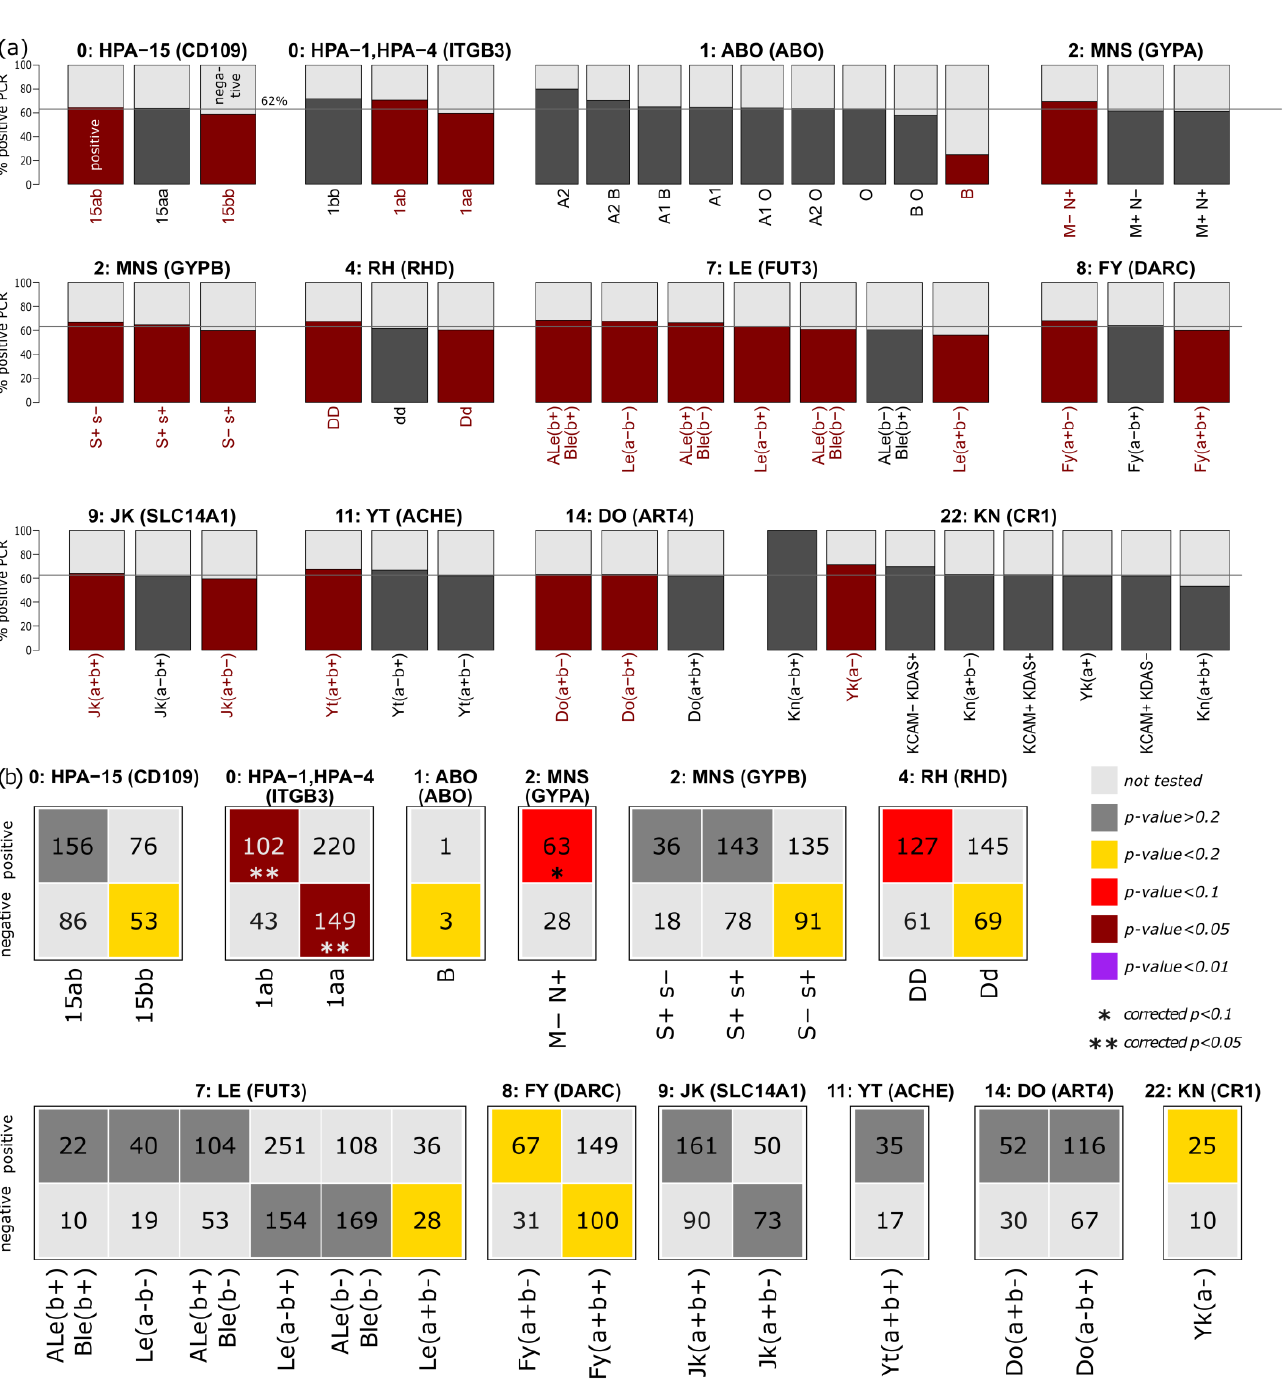
Figure 4. ( a ) Percent of persons with positive PCR, stratified by the blood groups. Groups with corrected p -values < 0.05 are highlighted in red (see description of Figure 2). ( b ) Contingency tables of the selected phenotypes (corrected p -value < 0.05). Numbers refer to all persons with the respective phenotype, split by positive and negative PCR status. Colors indicate significance of enrichment as obtained from Fisher’s exact test (see figure legend). Enrichments with p -values < 0.1/0.05 after Bonferroni correction are highlighted with asterisks.